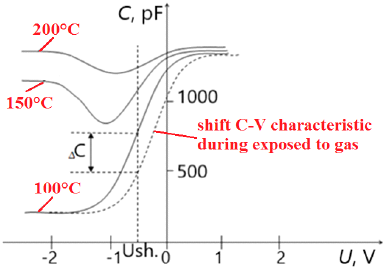
Figure 3. Scheme of capacitance-voltage characteristic for Pd gate sensor at different heating temperatures and shift C-V characteristic during exposed to gas.